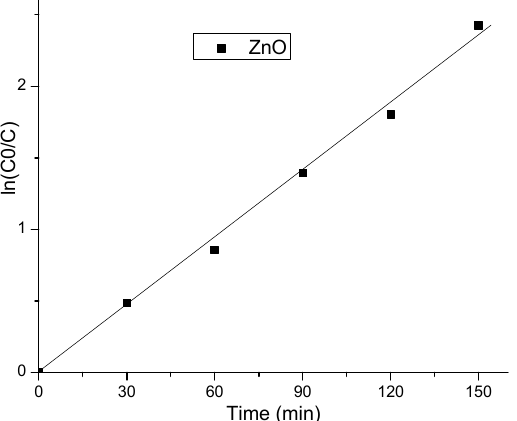
Figure 8. The pseudo-first-order rate constant k app (min − 1 ) was calculated from the slope of versus irradiation time t . ln(C0/C) versus irradiation time t.